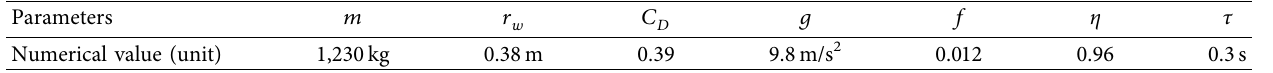
Table 2: Vehicle model parameters [22, 24].